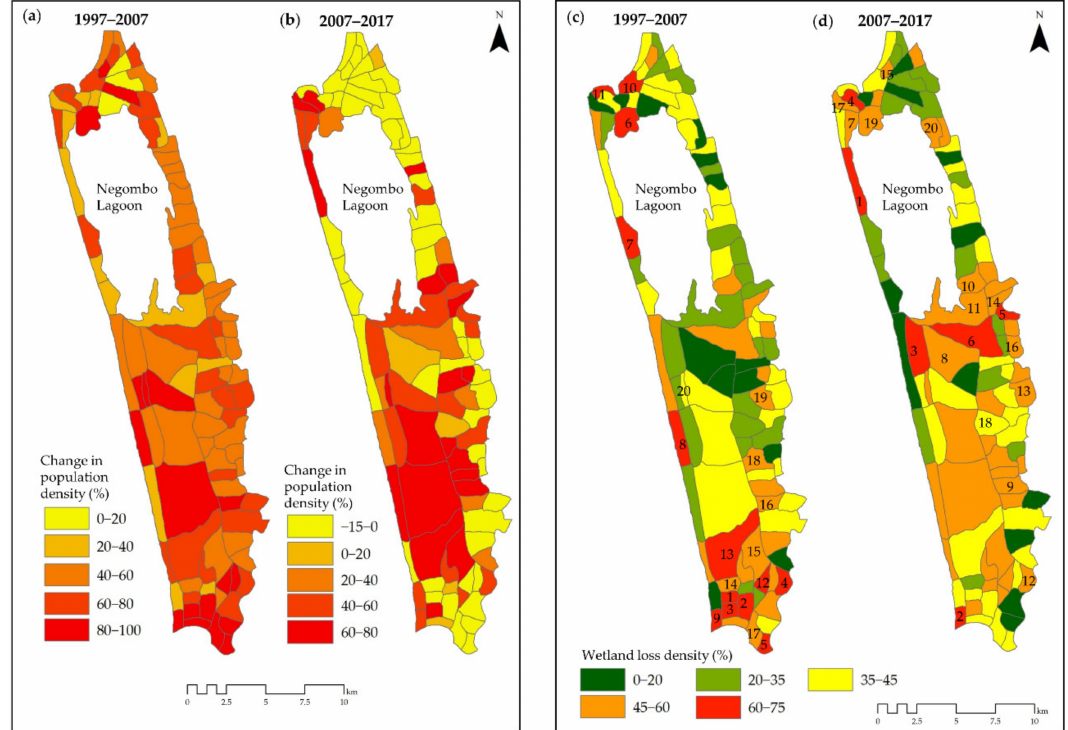
Figure 5. GN-level change in population density (CPD) ( a , b ) and density of wetland loss due to urbanization (settlement expansion) (WLD) (c and d) in the MMNL. Wetland includes water, mangrove, and marshland. The numbers on maps ( c , d ) refer to the numbers of the GNs in Appendix A Table A2.